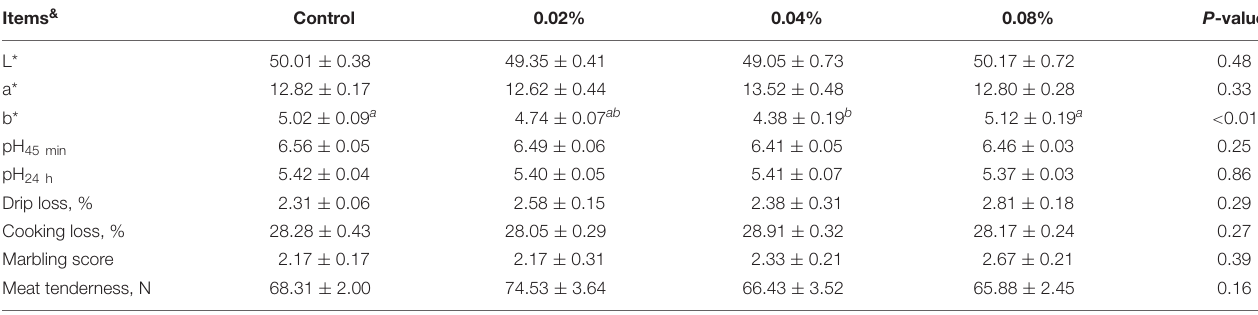
TABLE 3 | Effects of different levels of dietary CGA supplementation on meat quality of the finishing pigs. Items &